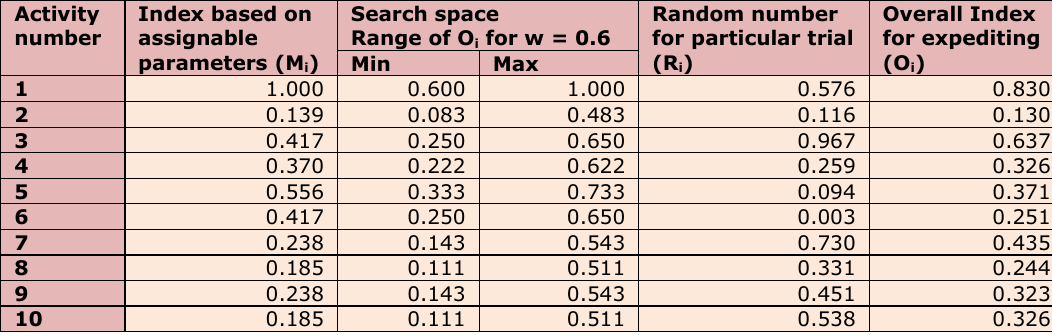
Table 2. Search Space for selection of best solution from trials